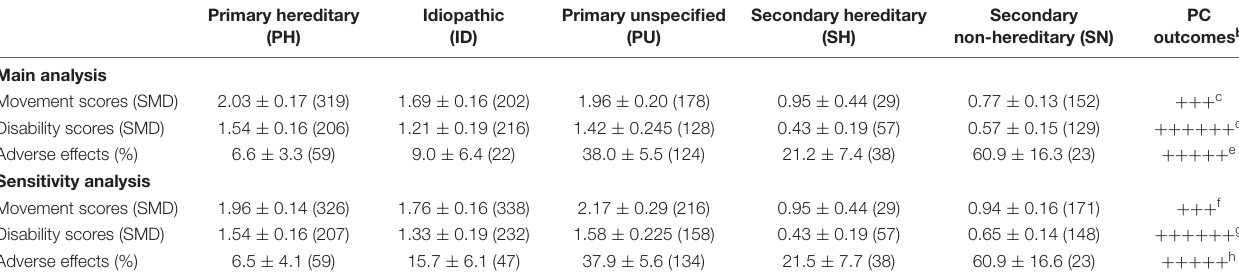
TABLE 4 | The main and sensitivity analyses of the surgery-related outcomes after DBS in the etiology subgroup a .